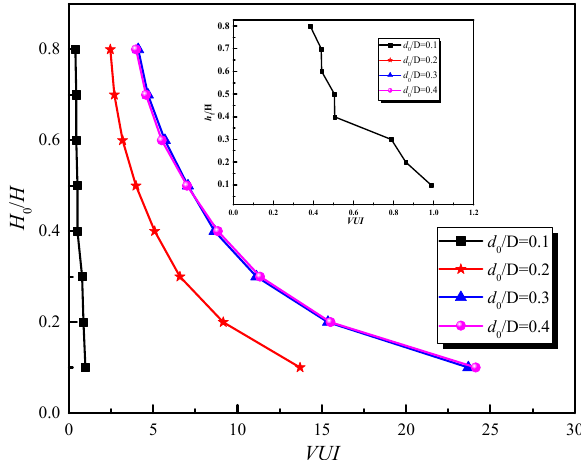
Figure 13. The variation in VUI in sinter layers with different normalized outlet scales and inset. VUI varies with sinter layers at the normalized outlet equal to 1.